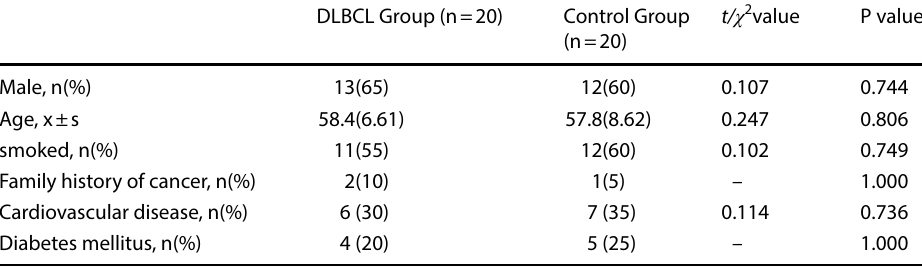
Table 1 Comparison of baseline data between patients with DLBCL and healthy